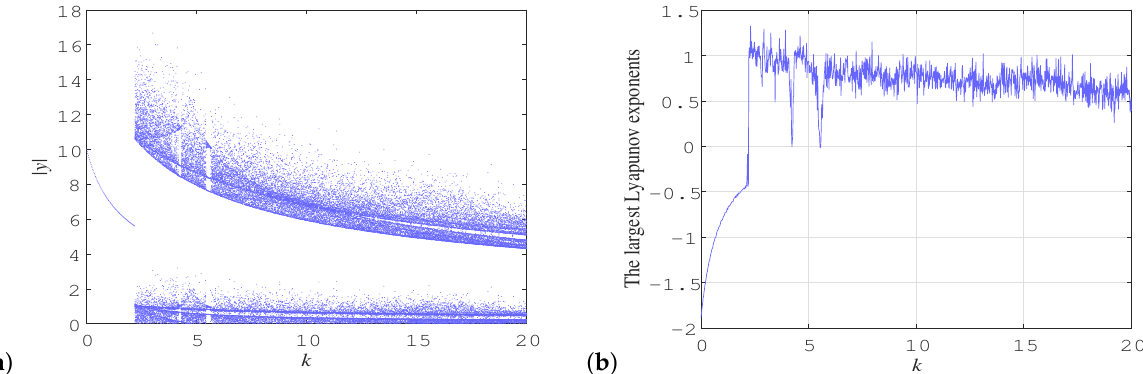
Figure 11. ( a ) Bifurcation diagram of | y | with k as the varied parameter and ( b ) the largest Lyapunov exponent spectrum, where a = 12, b = 100, and c =